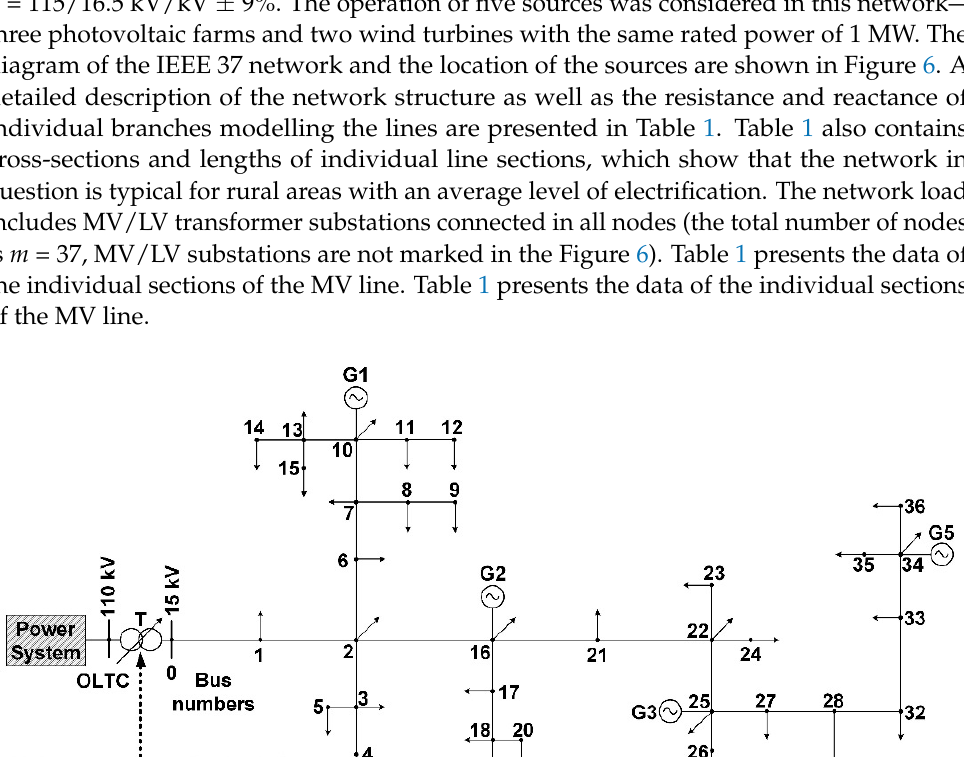
Figure 5. The Q ( U ) characteristic of the inverter of the RES installation (photovoltaic and wind farm) selected for the analysis of the effectiveness of the voltage regulation in the MV grid.